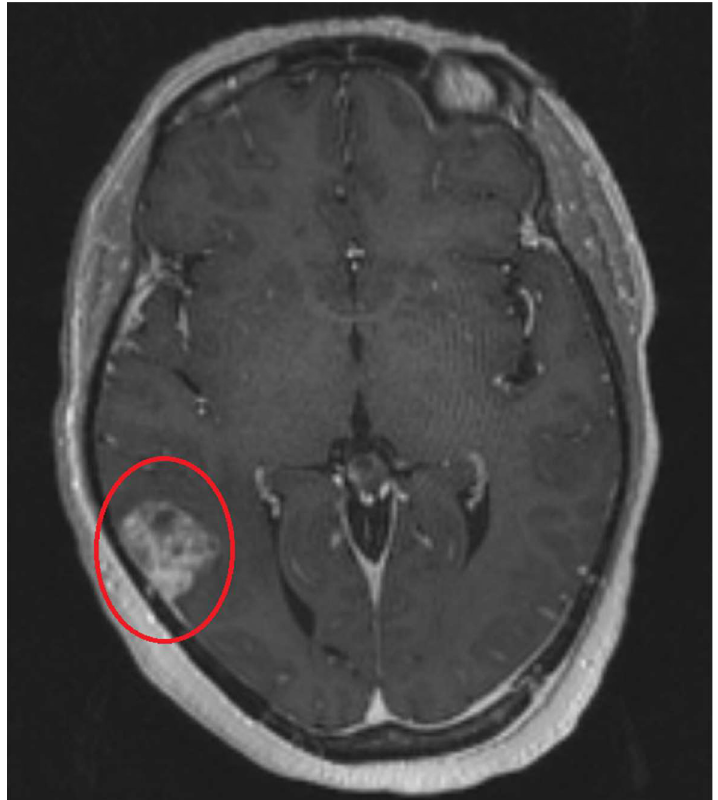
Figure 1. A T1 post-contrast axial magnetic resonance image of a contrast-enhancing tumor (circled in red). This patient is a 57-year-old female with metastatic breast carcinoma. The image and presentation are consistent with a brain metastasis.